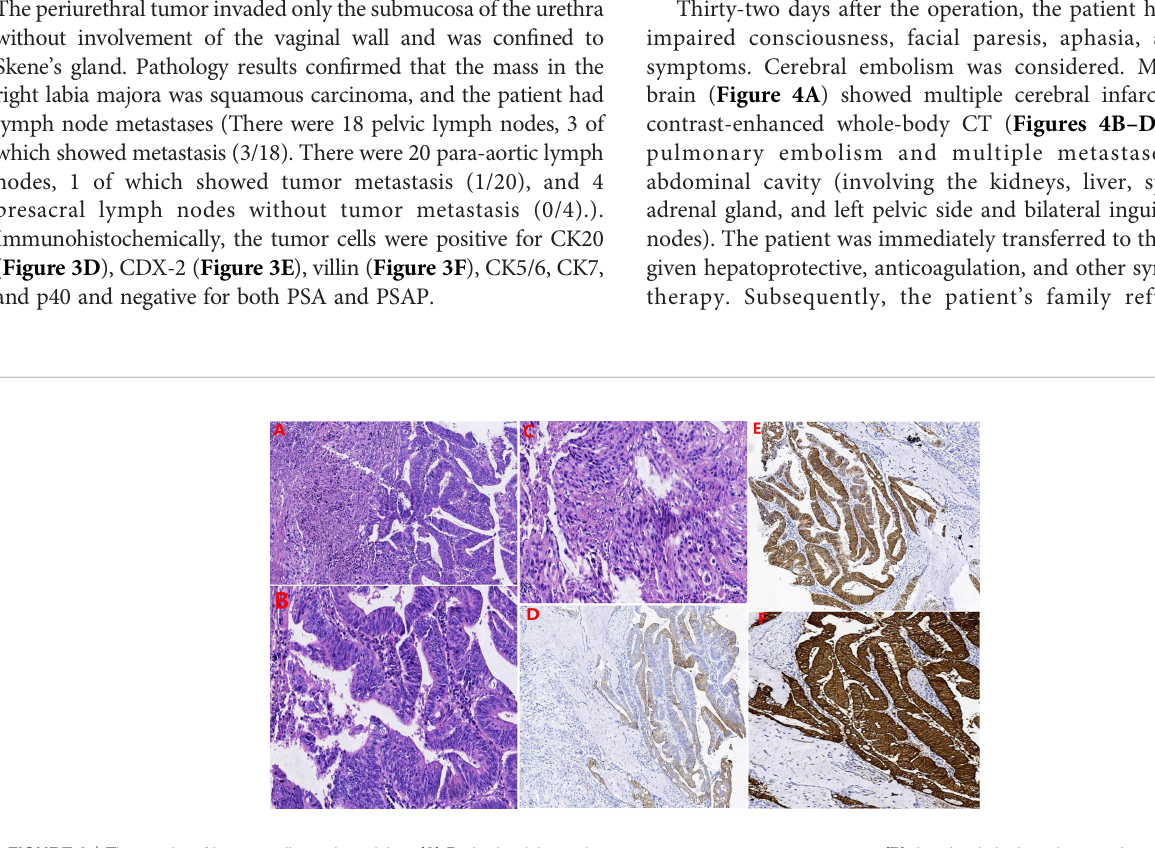
FIGURE 3 | The results of hematoxylin-eosin staining: (A) Both glandular and squamous components were present. (B) the glands in the adenocarcinoma area were cribriform, papillary arrangements and had patterns of invasive growth. (C) The area of squamous carcinoma displayed nest distribution, patchy necrosis, pathological nuclear division, and invasive growth. Immunohistochemically: the tumor cells were positive for (D) CK20, (E) CDX-2, and (F)